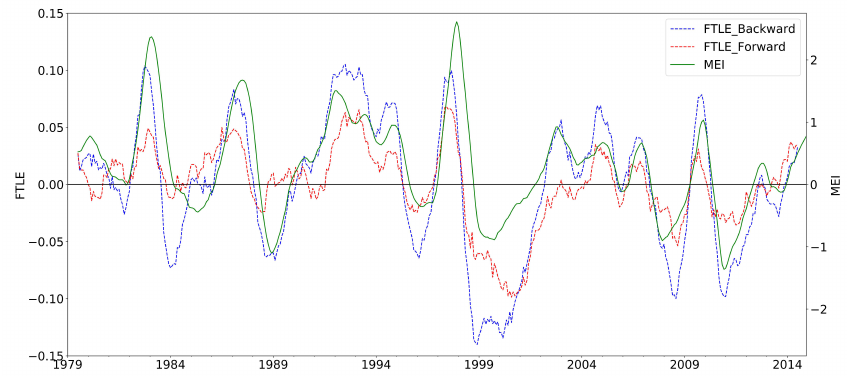
Figure 4. Monthly time evolution of the backward and forward FTLE anomalies and the MEI for the 1979–2014 period.